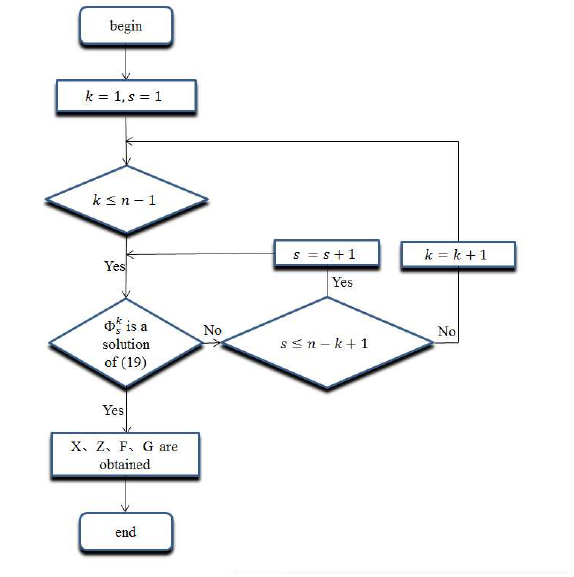
Figure 1. Flowchart of the